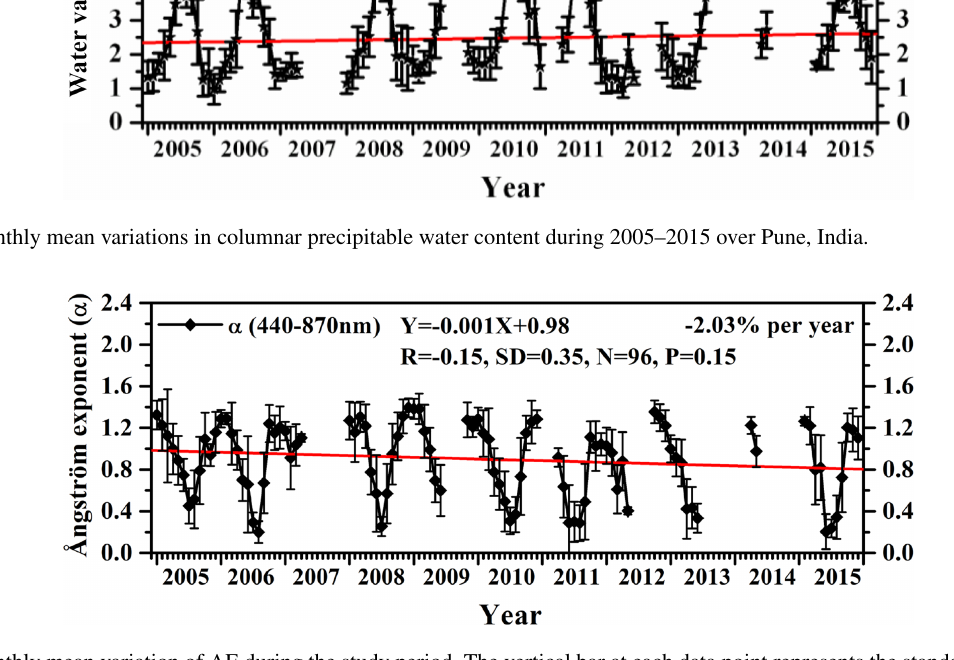
Figure 12. Monthly mean variation of AE during the study period. The vertical bar at each data point represents the standard deviation from the mean. The solid red line indicates long-term decreasing